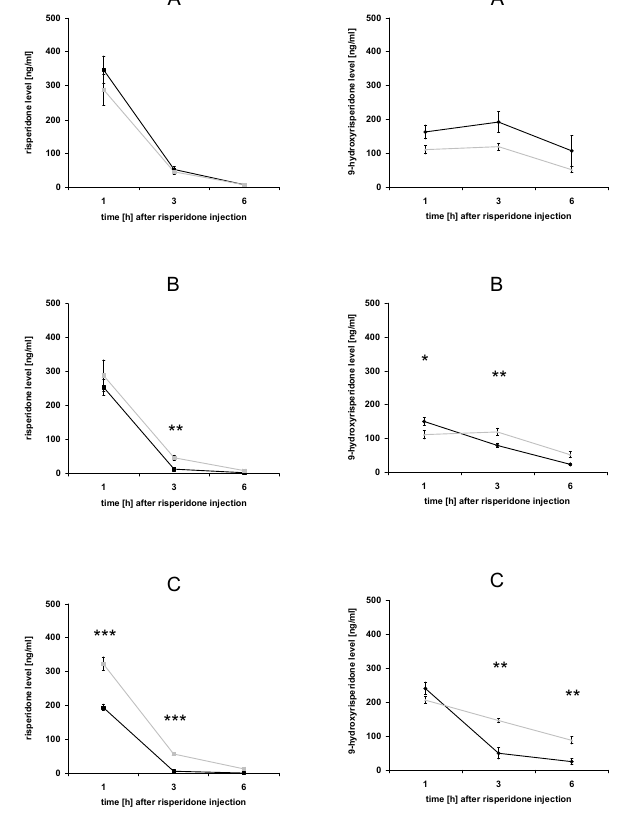
Figure 4. Serum concentrations of risperidone and 9-hydroxyrisperidone. Serum concentrations of risperidone (left side) and 9-hydroxyrisperidone (right side) after drug transporter induction with 10 mg/kg/d rifampicin (A), 50 mg/kg/d dexamethasone (B) or 25 mg/kg/d PCN (C) vs. controls for 4 days. Drug transporter induced mice = black lines, controls = grey lines. Data are mean + /- S.E.M. (*p < 0.05; ** p < 0.01; *** p <